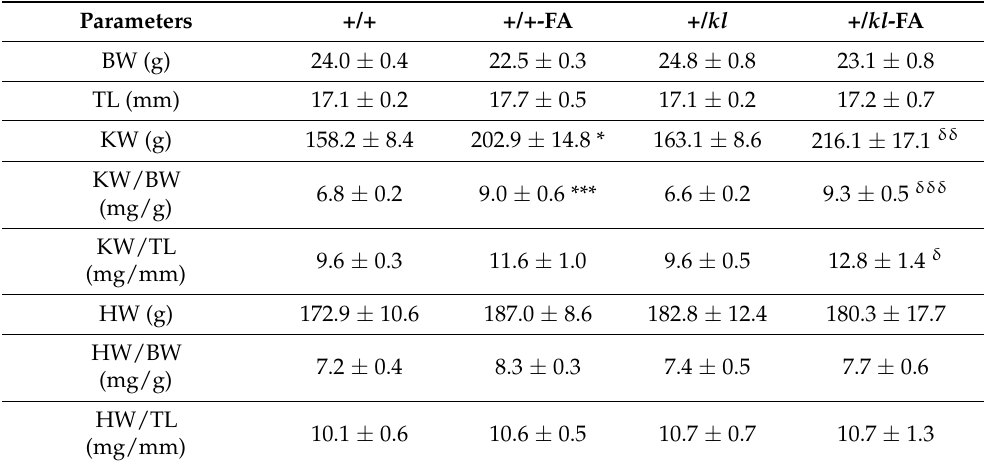
Table 1. Macroscopic parameters in +/+ and +/kl mice after AKI. Parameters